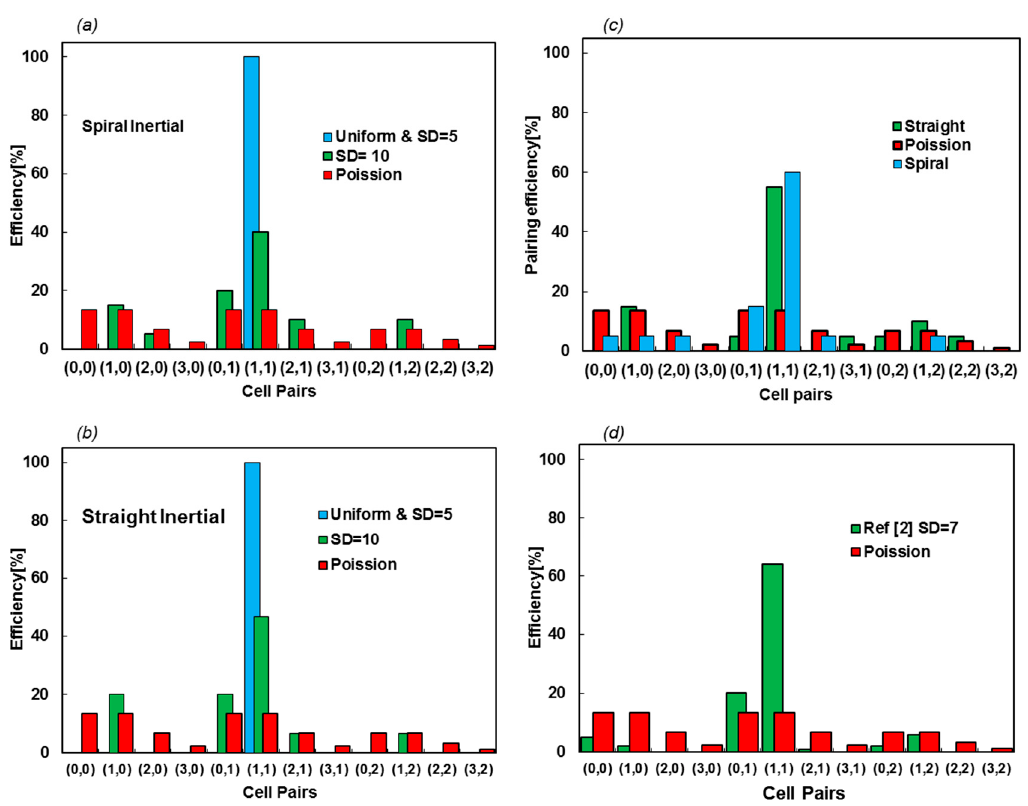
Figure 10. ( a , b ) Encapsulation efficiency of spiral and straight inertial focusing devices for two SD values of 5 and 10 µ m. The scattering of the droplet contents shows similar productivity for both devices; other than small variations in the cell pair scattering, changing the focusing channel type does not affect the efficacy of the encapsulation. ( c ) The pairing efficiency increases by lowering the frequency. The frequency is reduced by increasing σ to 0.065 N/m. ( d ) The efficiency values and scattering cell pairs are from [2], with an approximate SD of 7 μ m.